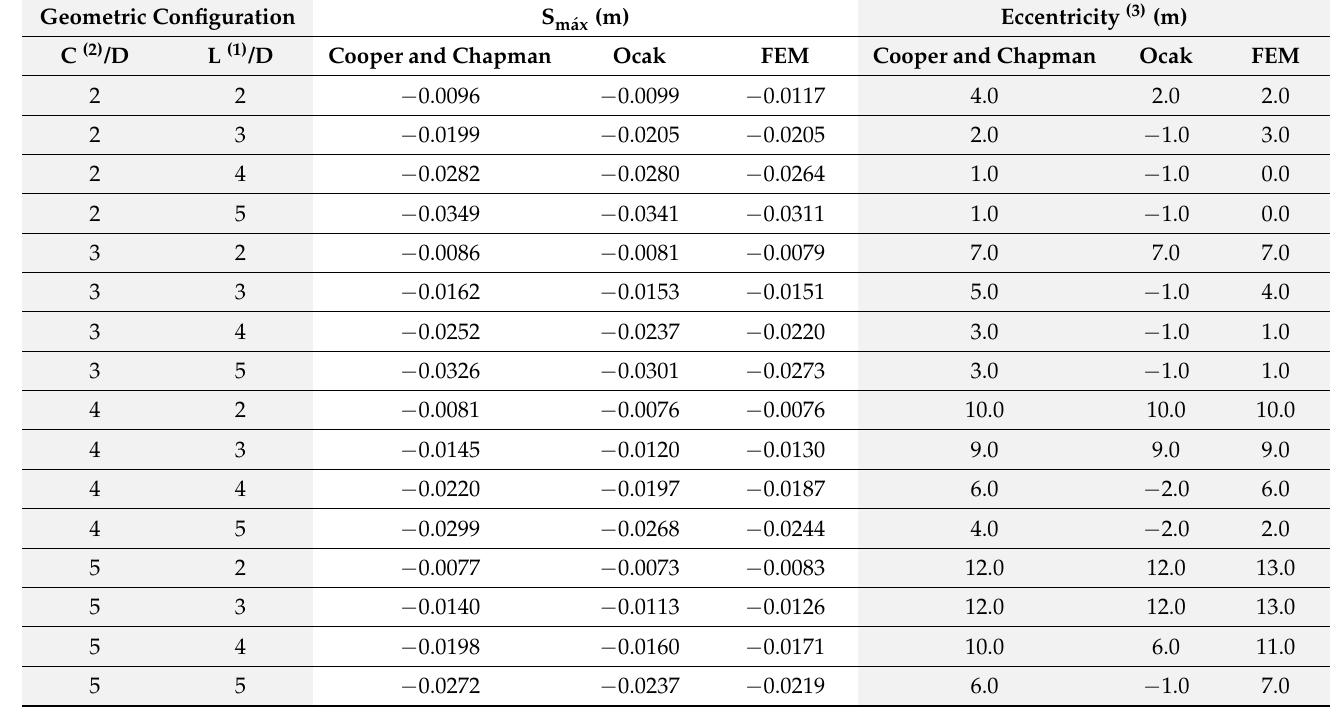
Table 5. The eccentricity of the maximum settlement.